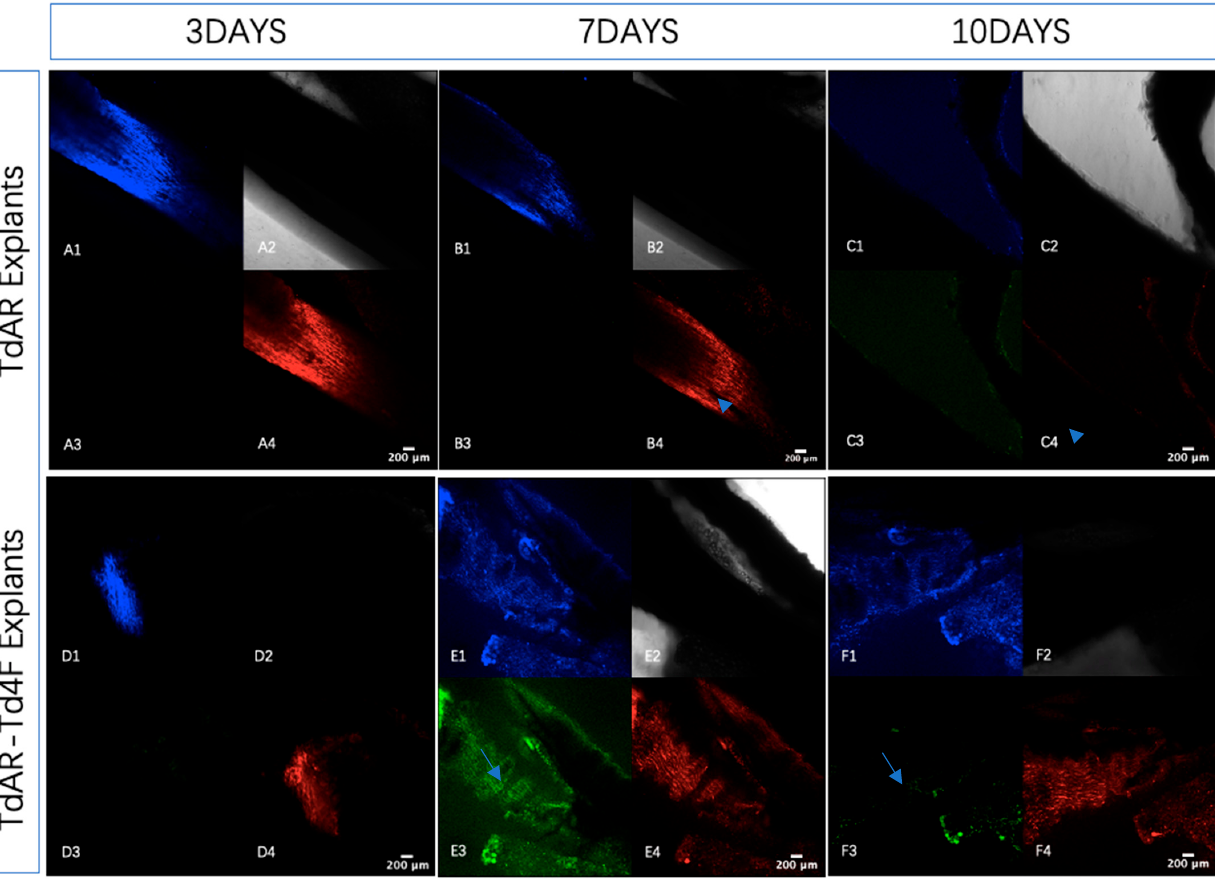
Figure 3. Transient Td4F overexpression in explant cultures prolonged the expression of Scx-Scarlet and Col1a1-BFP. For the in vitro analysis of tendon transcription factor expression in Achilles tendon cells, Achilles tendons from 6-week-old transgenic mice were collected. The expression of mScarlet and BFP was then progressively reduced in Achilles tendons deprived of mechanical traction during the culture of the Achilles tendon explants. The experiment was repeated three times independently using Achilles tendon explants from different donors. ( A – C ) show Achilles tendon explants from TdAR mice cultured for three, seven and ten days, respectively, under confocal microscopy (×10 magnification); 1 – 4 are views under confocal microscopy of Col1a1-BFP ( A1 – F1 ),